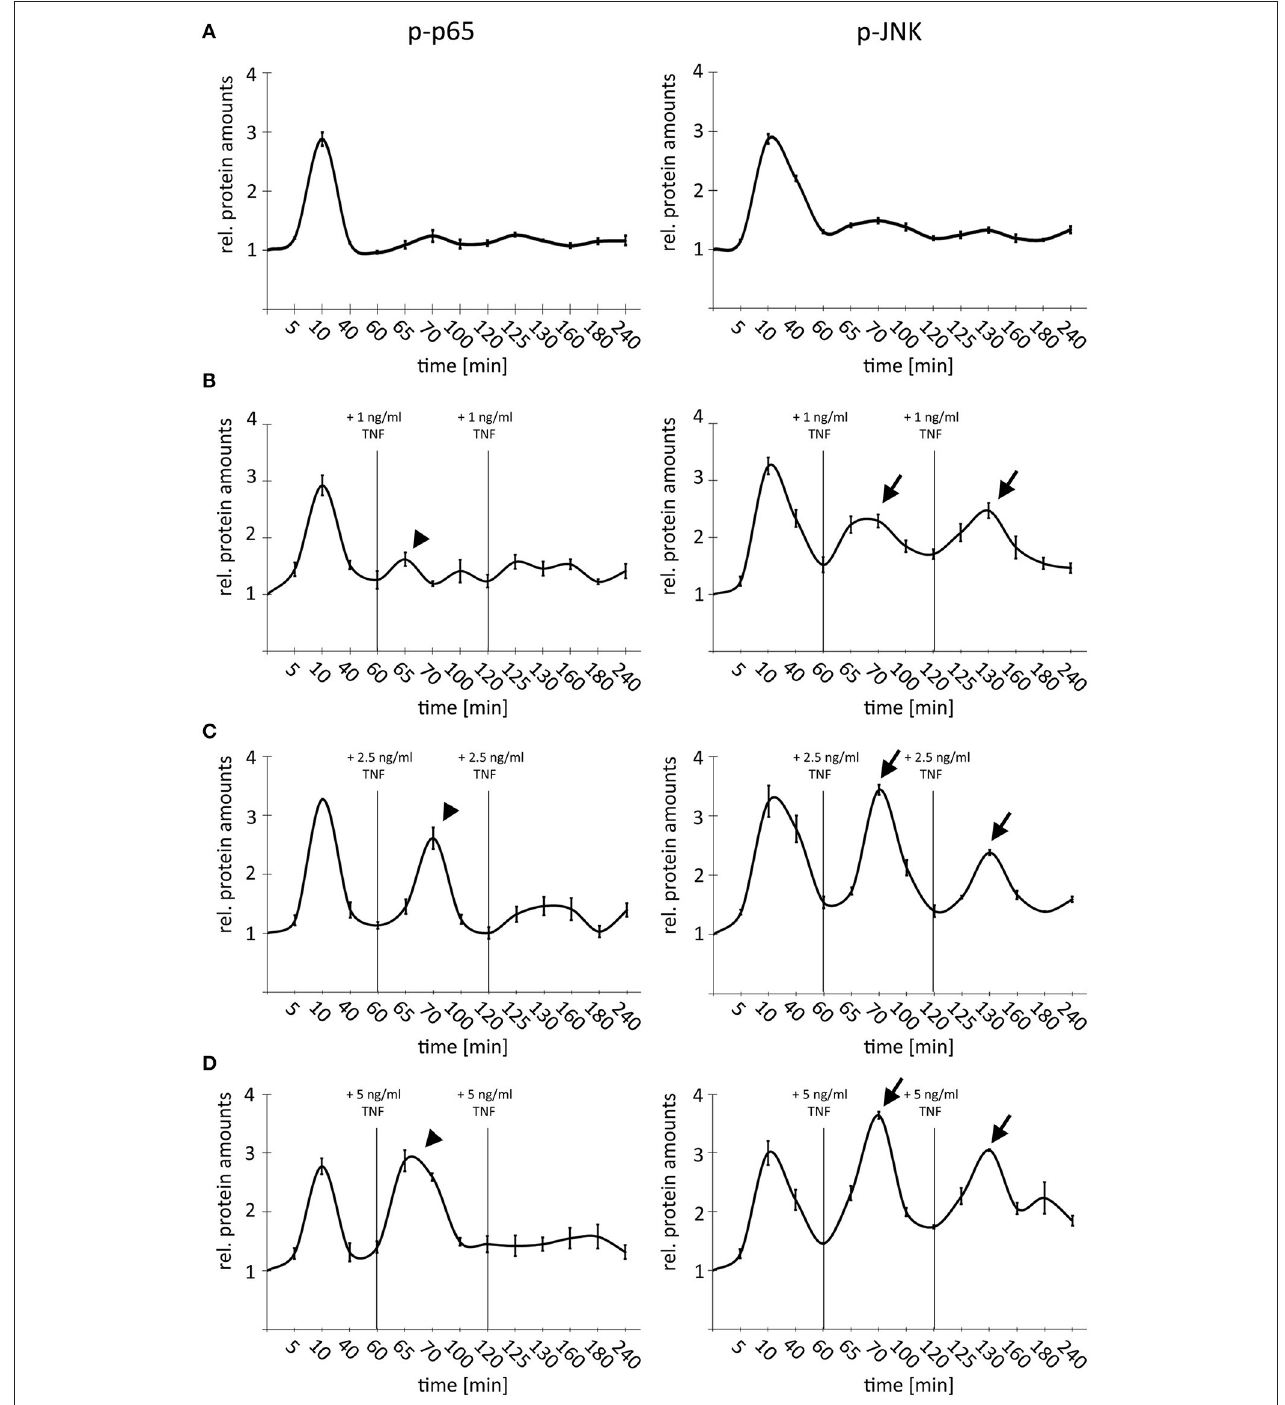
FIGURE 4 | Comparison of NF- κ B and JNK pathway activity after single and multiple TNF stimulation. (A) Single TNF treatment of Hepa1-6 cells (1 × 1 ng/ml). (B) Triple TNF treatment Hepa1-6 cells with 3 × 1 ng/ml. (C) Triple TNF treatment Hepa1-6 cells with 1 × 1 ng/ml followed by 2 × 2.5 ng/ml. (D) Triple TNF treatment Hepa1-6 cells with 1 × 1 ng/ml followed by 2 × 5 ng/ml. For all graphs signals for p65/phospho-p65, and JNK/phospho-JNK were quantified and normalized to the respective loading control (actin). For (B–D) additional treatments and respective TNF concentrations are indicated. Arrowheads indicate p-p65 responses while arrows indicate p-JNK responses. Graphs summarize the results from three independent analyses. Bars represent standard errors.